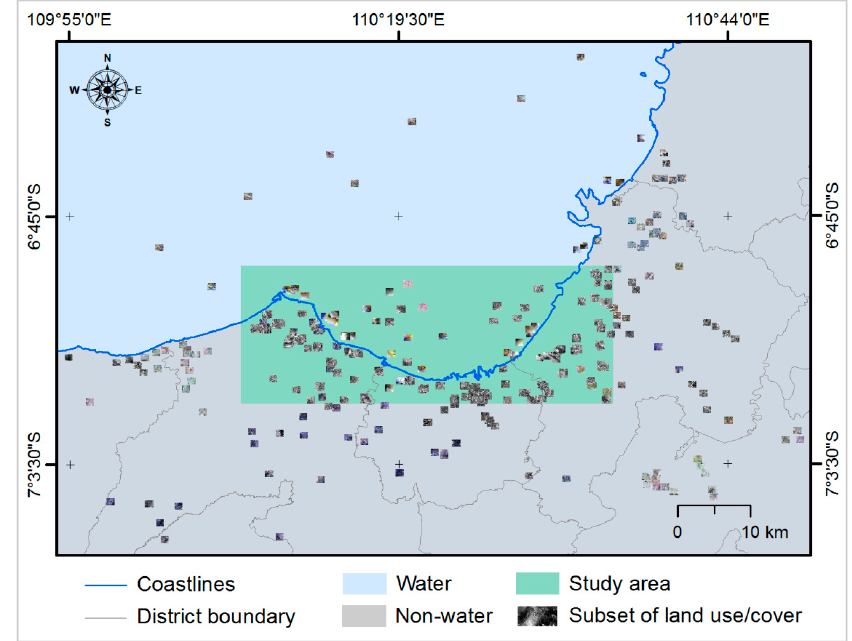
Figure 3. Location of subsets for each land use/cover class in the cities of Semarang, Kendal and Demak.